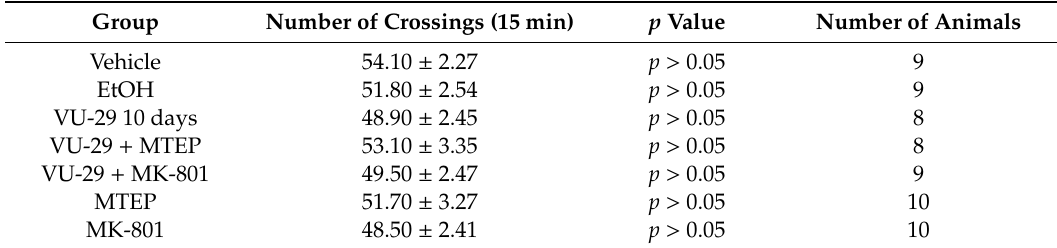
Table 3. The influence of MK-801 and MTEP on the effect of VU-29 administration to ethanol- conditioned rats on locomotor activity measured as the number of crossings from one compartment to another during 15 min of Test 2. Results are expressed as mean ± SEM.